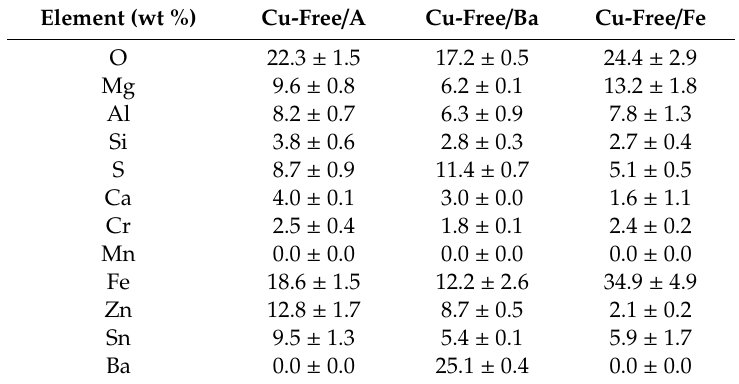
Table 1. Elemental composition, in weight percentage, of the three investigated friction